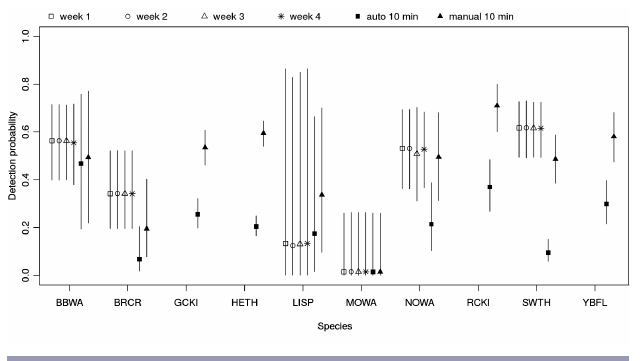
Fig. 2 . Detection probability of forest birds based on single 10- min recordings and multiple recordings pooled within each week collected with automated recording units in 2013 and 2014 at 109 stations in Hearst Forest Sustainable Forest License, Ontario, Canada. Solid symbols indicate detection probability based on a single 10-minute recording (triangles represent manual detection and squares represent automated song recognition). Open symbols indicate estimated detection probability for multiple recordings pooled into four separate weeks. These symbols represent detection probability based on 35 to 63 10-minute recordings). Error bars represent 95% confidence intervals. See Table 4 for species